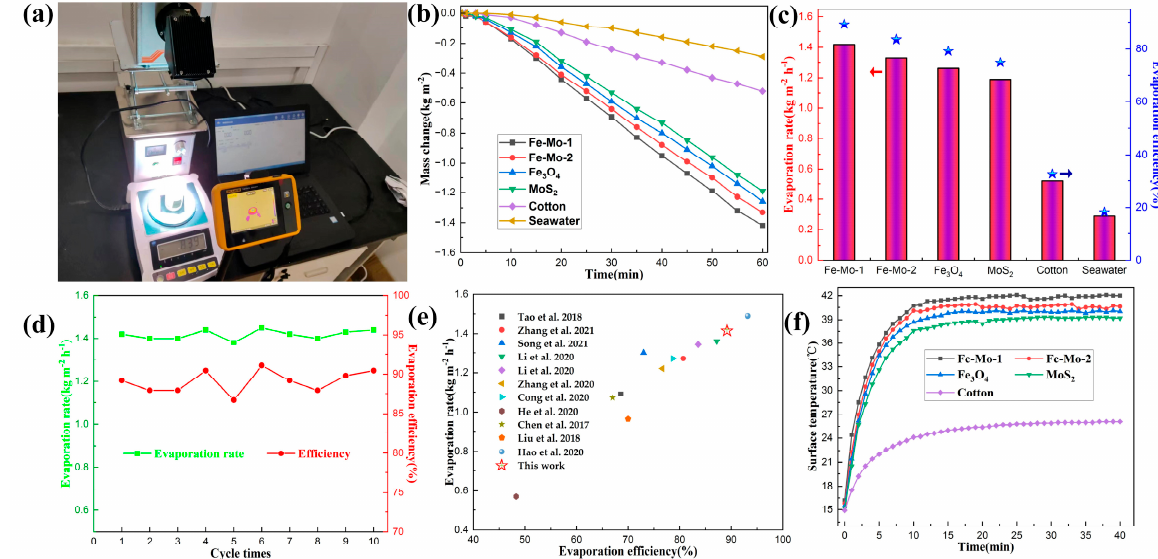
Figure 3. ( a ) Physical picture of the SSG test device in the laboratory. ( b ) Variation of the change in seawater mass with time for different samples under one sun irradiation. ( c ) Seawater evaporation rate and efficiency of different samples under one sun irradiation (The bar graph corresponds to the evaporation rate on the left axis and the pentagram corresponds to the evaporation efficiency on the right axis). ( d ) Cyclic experiment of the Fe-Mo-1 sample under one sun irradiation. ( e ) Comparison of the evaporation rate and efficiency of the Fe-Mo-1 with other literature (The top to bottom plots correspond to refs. [8,12,19,27–34], respectively). ( f ) Trend chart of surface temperature changes over time for different samples during the SSG test.